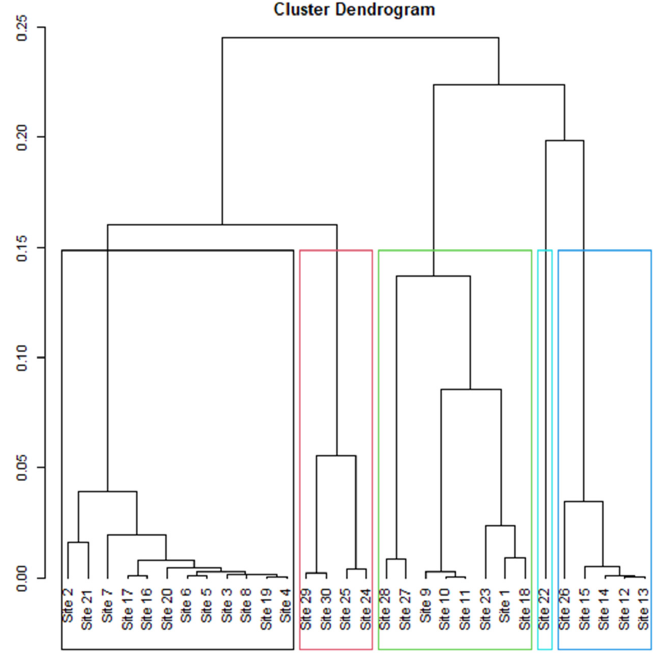
Figure 16. Hierarchical tree of instability classes. Each color is a different cluster (see Figure 17).